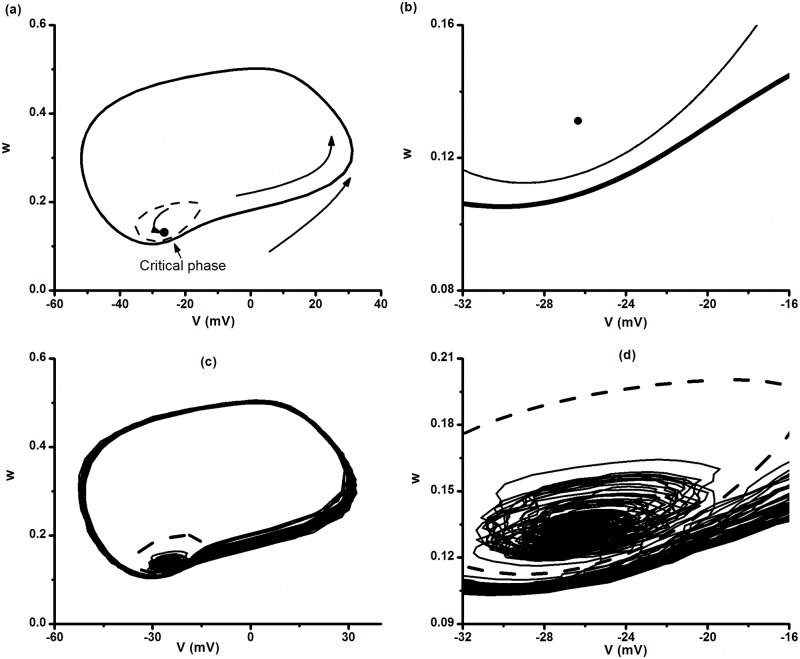
Trajectories in (V, w) plane in the ML model.
I = 90.7 μA/cm2 and V
K = -84 mV. (a) The stable focus (bold dot), unstable limit cycle (dashed line), and stable period-1 limit cycle (solid bold line) in the deterministic model; evolution of the stable limit cycle is anti-clockwise; (b) enlargement of Fig 10(a) near the critical phase; (c) unstable limit cycle (dashed line) and the on-off firing pattern (solid line) in the stochastic ML model when D = 0.04 (μA)2/cm4; (d) enlargement of Fig 10(c) near the critical phase.